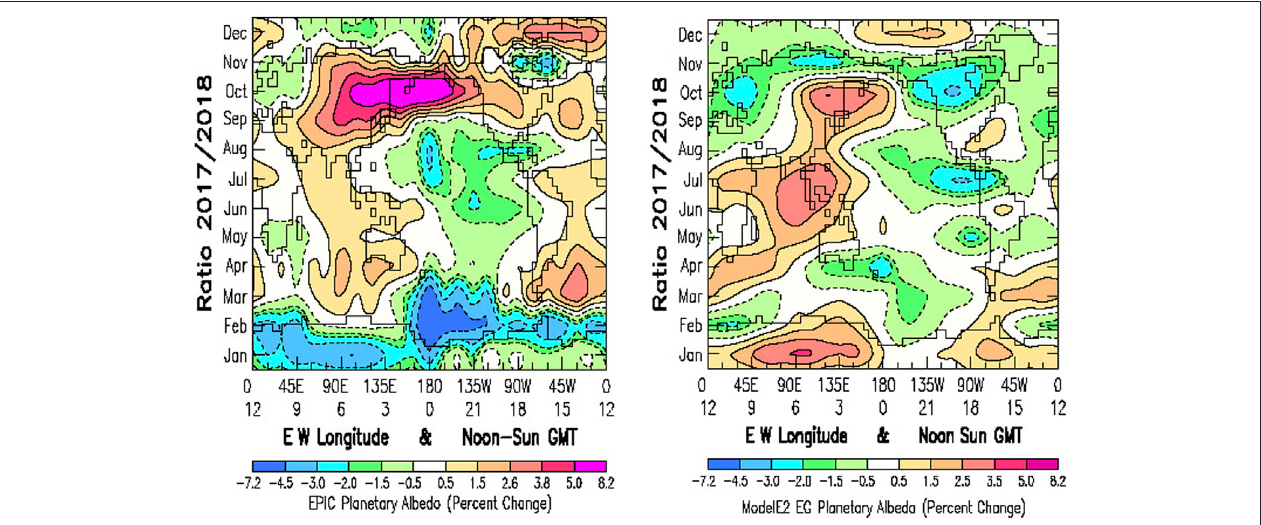
FIGURE 4 | Hovmöller-styleratio plot of year 2017 divided by year 2018 ofthe EPIC (Left) and ModelE2 (Right) planetary albedo plotted in Figure 3 . The Y-scale hastimerunningupwardstartingwithJanuaryatthebottomthroughDecemberatthetop.Asin Figure3 ,theX-scaleislongituderunningfrom0 ° Elongitudeattheleftto 0 ° W longitude at the right. GMT references the location of high-noon Sun. The world map is included for geographic reference.